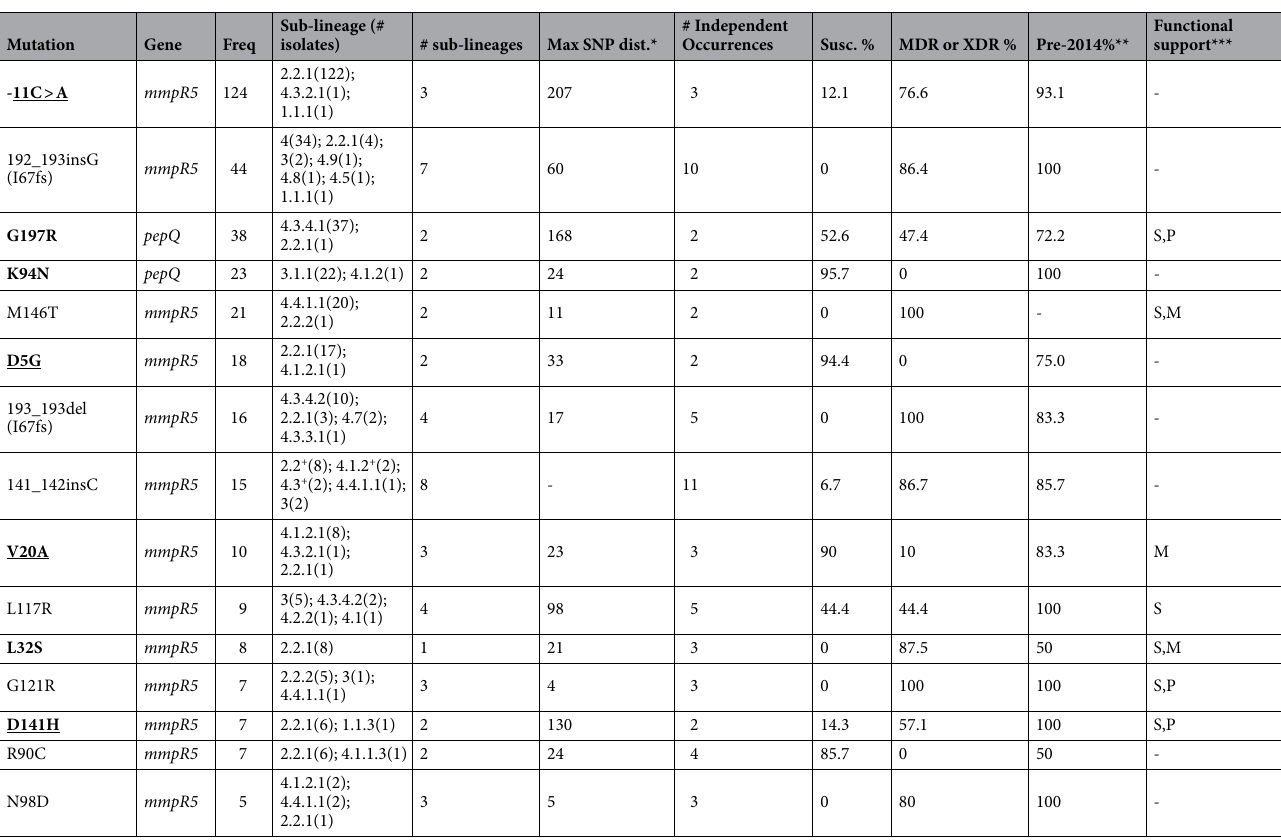
Table 2. Mutations in bedaquiline candidate genes occurring in at least 5 samples and more than one independent clade. Sub-lineages: + = more than 1 sub-lineage; # = number; * Maximum SNP distance calculated in clades of ≥ 5 isolates; Drug resistance (%): Susc. = Susceptible; ** % of number of samples pre-2014/total number of samples with available collection date; *** Functional support: S = snap2 score ≥ 50; P = Provean Score ≤ −4; M = mCSM predicted stability change (ΔΔG) below − 2. Mutations associated with increased MIC for BDQ in previous studies in bold ; mutations associated with susceptibility to BDQ underlined (see S3